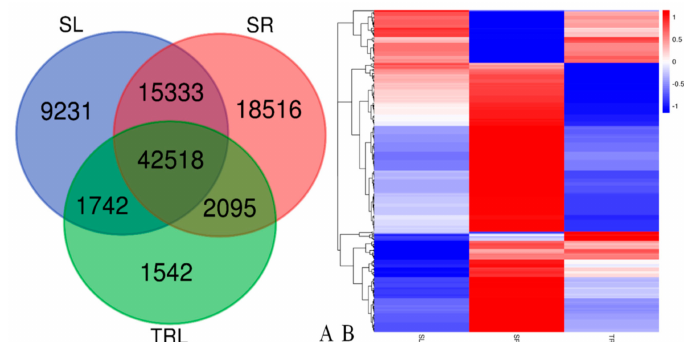
Figure 4. ( A ) Three-way Venn diagram showing the numbers of shared and unique expressed genes across the three tissues. ( B ) Di ff erentially expressed transcription factors. Heat map showing transcription factors with di ff erential expression (fold ≥ 1, FDR ≤ 0.001) among the three replicates of the SR (root), SL (sporophyll), and TRL (sporophyll with glandular trichomes removed). Expression values are log2-transformed and median-centered by gene. Scaled log2 expression values are shown, with red and blue indicating high and low expression,